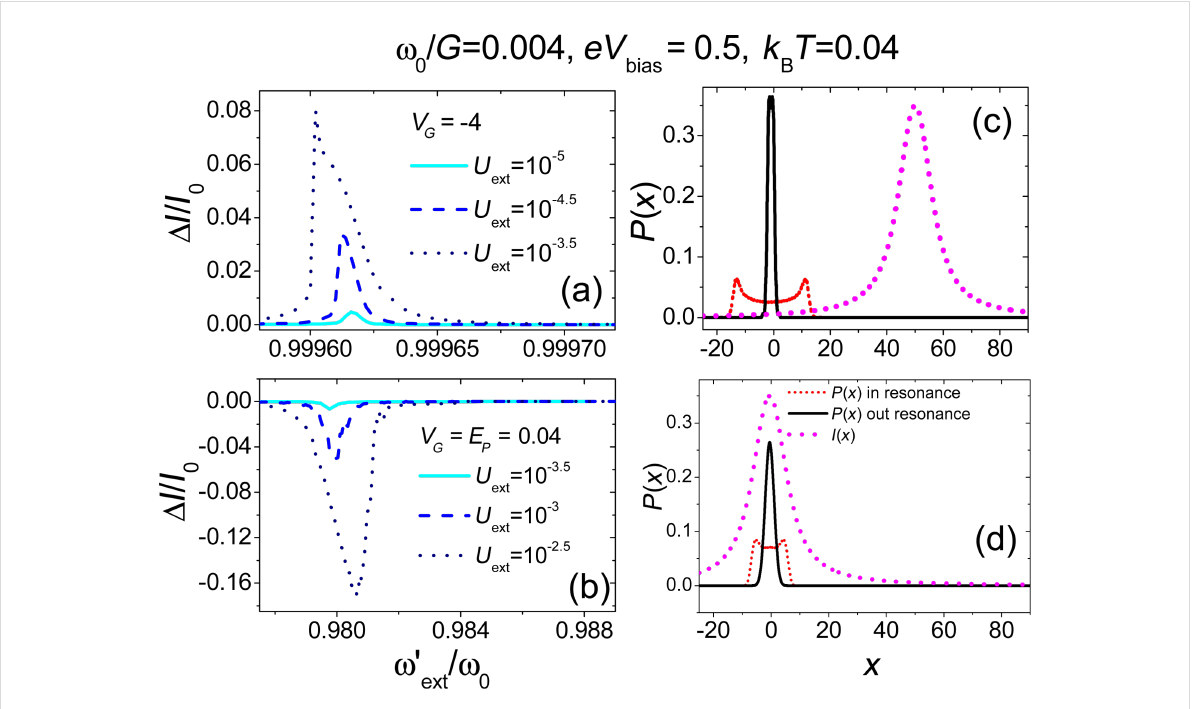
Figure 10: Electronic transport properties in the presence of an external periodic time-dependent perturbation. Panel (a) and panel (b): Normalized current change ( Δ I / I 0 ) as a function of the external frequency ( ) for different antenna amplitudes. Panels (c) and (d) show the distribution P ( x ) both out of mechanical resonance and at mechanical resonance for the larger value of antenna amplitude considered in panels (a) and (b). The short- dashed line (magenta) represents current as function of position I ( x ). Adapted from [77].